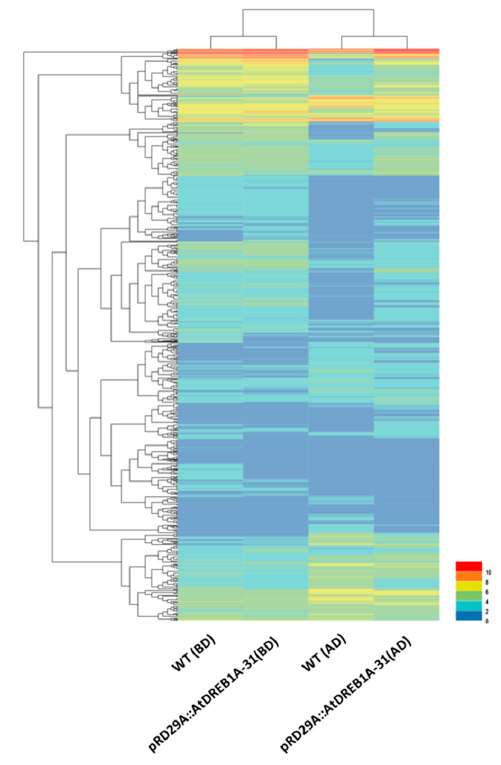
Figure 2. Cluster analysis of DEGs in WT and AtDREB1A -expressing transgenic Salvia miltiorrhiza plants based on expression profiles measured by RNA-seq. WT, wild type; pRD29A::AtDREB1A-31, pRD29A::AtDREB1A transgenic line 31. BD, before drought; AD, after six days of drought. The color scale in the heat map corresponds to log2 (FPKM) values of genes in various samples.